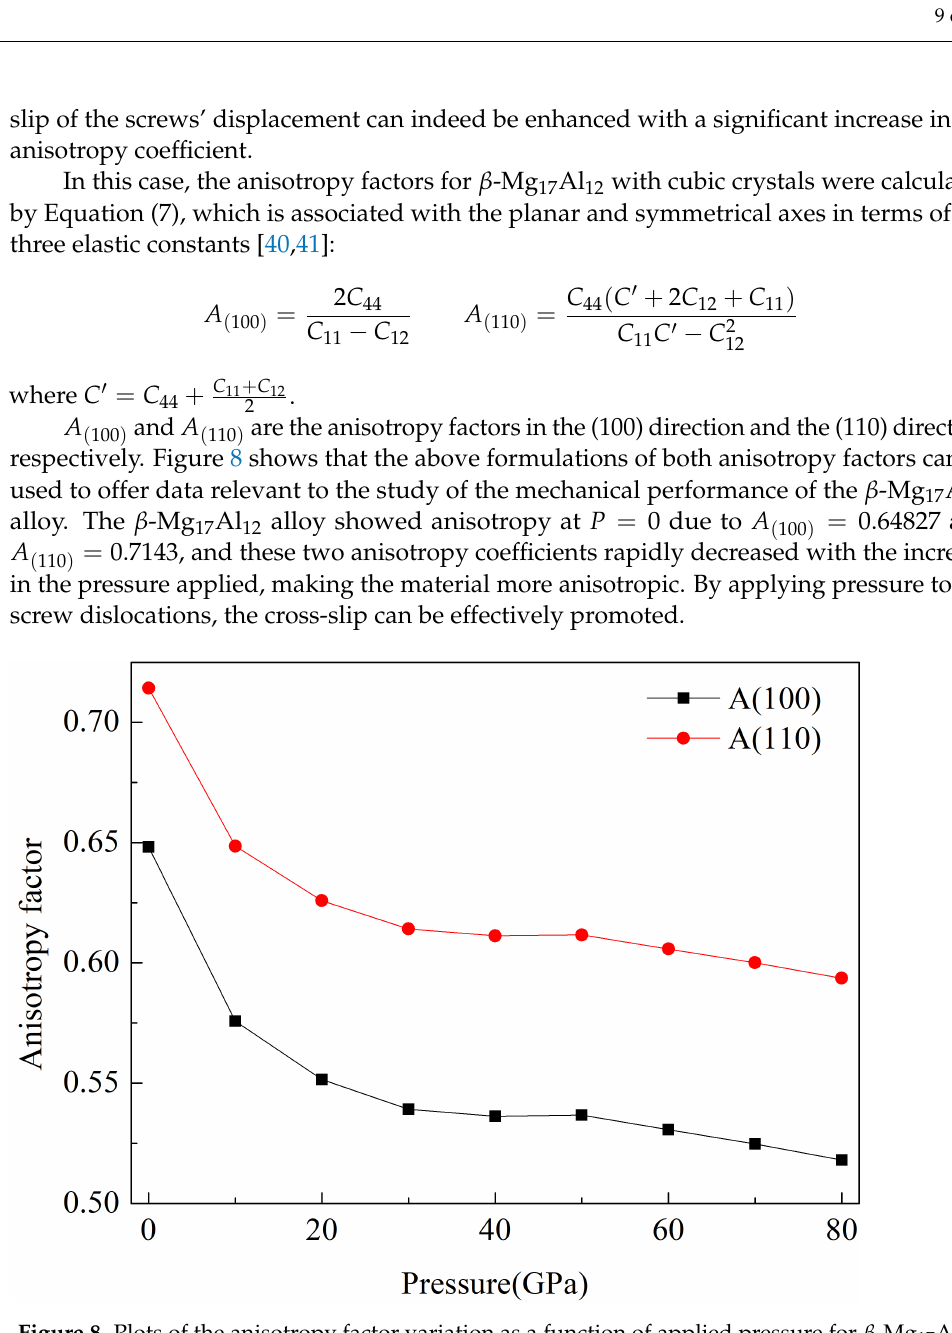
Figure 8. Plots of the anisotropy factor variation as a function of applied pressure for β -Mg 17 Al 12